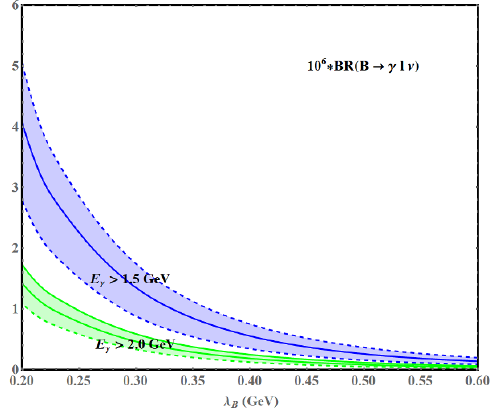
Figure 9 . Dependence of the partial branching fractions BR ( B ! (cid:13)‘(cid:23); E (cid:13) (cid:21) E cut ) on the (cid:12)rst inverse moment (cid:21) B ( (cid:22) 0 ) for E cut = 1 : 5 GeV (blue band) and E cut = 2 : 0 GeV (green